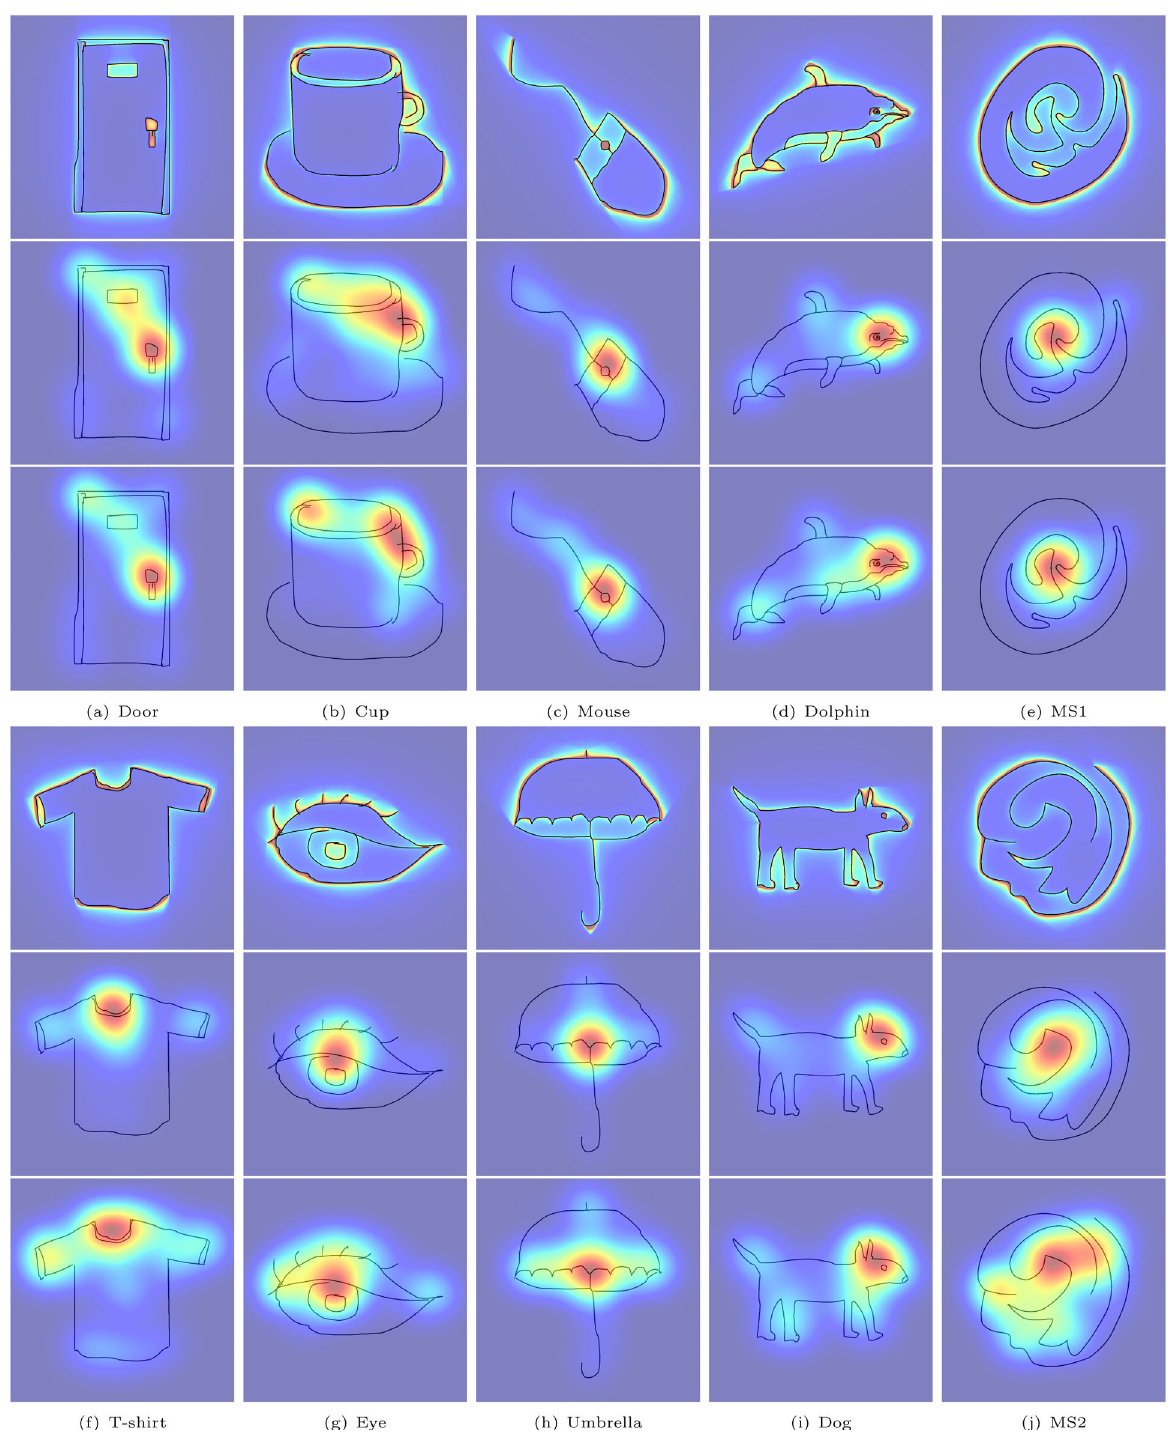
Fig. 5 Visualization of PPFs and fixation maps for each stimulus shown in Fig. 3. Top: PPF results. Middle: fixation maps for the free-viewing task. Bottom: fixation maps for the observation task.